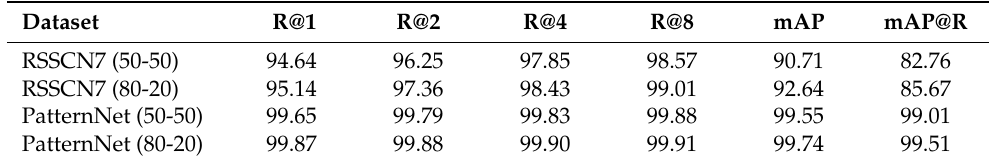
Table 8. Recall@K(%), mAP, and mAP@R performance comparison on RSSCN7 and PatternNet with different Dataset division